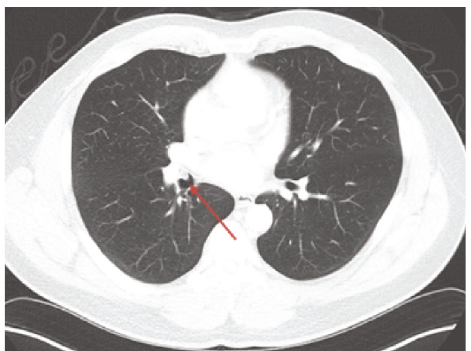
Figure 2: CT chest, axial view: red arrow denoting a 15mm intraluminal, lobulated exophytic soft lesion at the origin of the right middle lobe.